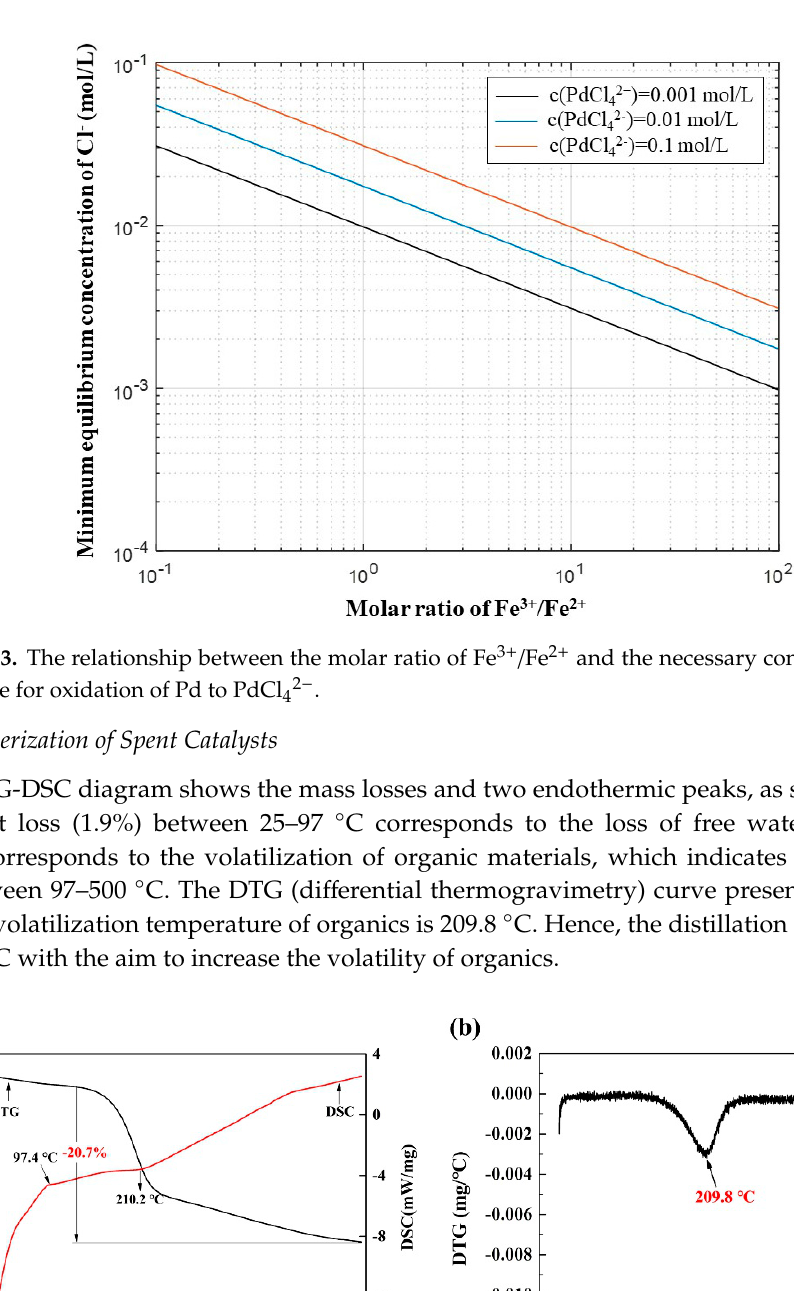
Figure 2. Equilibrium potentials for semi-reaction of Pd reduction in chloride media.